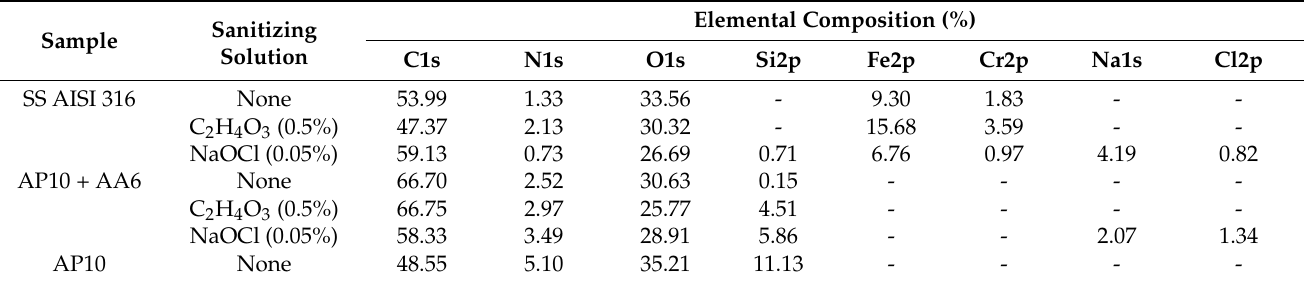
Table 1. Elemental composition of the studied surfaces. Hyphens (-) indicate undetected